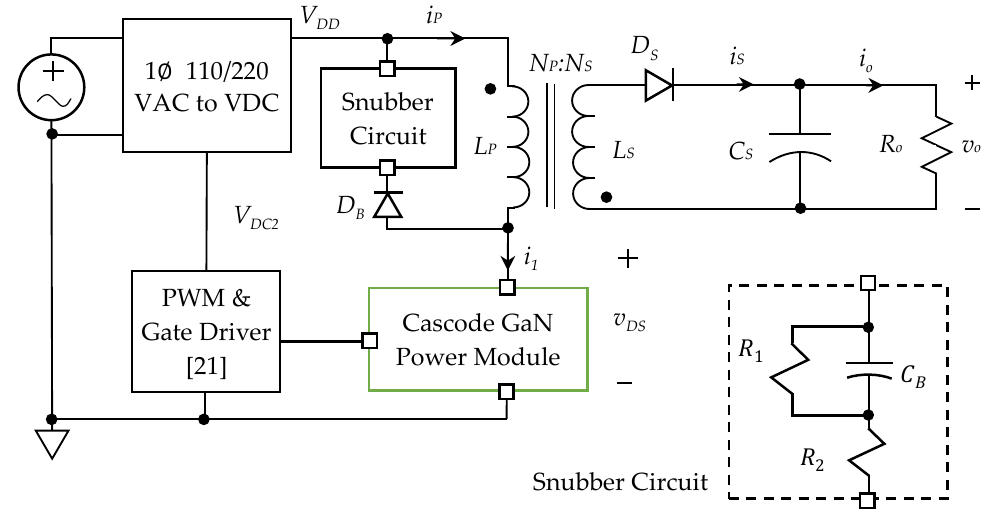
Figure 11. Topology of the flyback converter. Table 4. Parameters of the flyback converter.